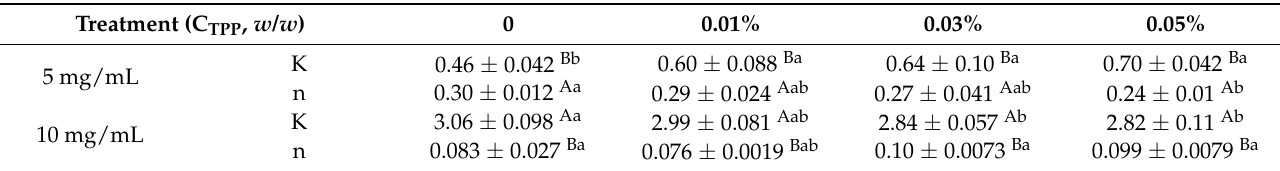
Figure 6. The viscosity of MP solution and O/W emulsion with different concentration of TPP. Table 4. Effects of TPP on EAI and ESI of MP O/W